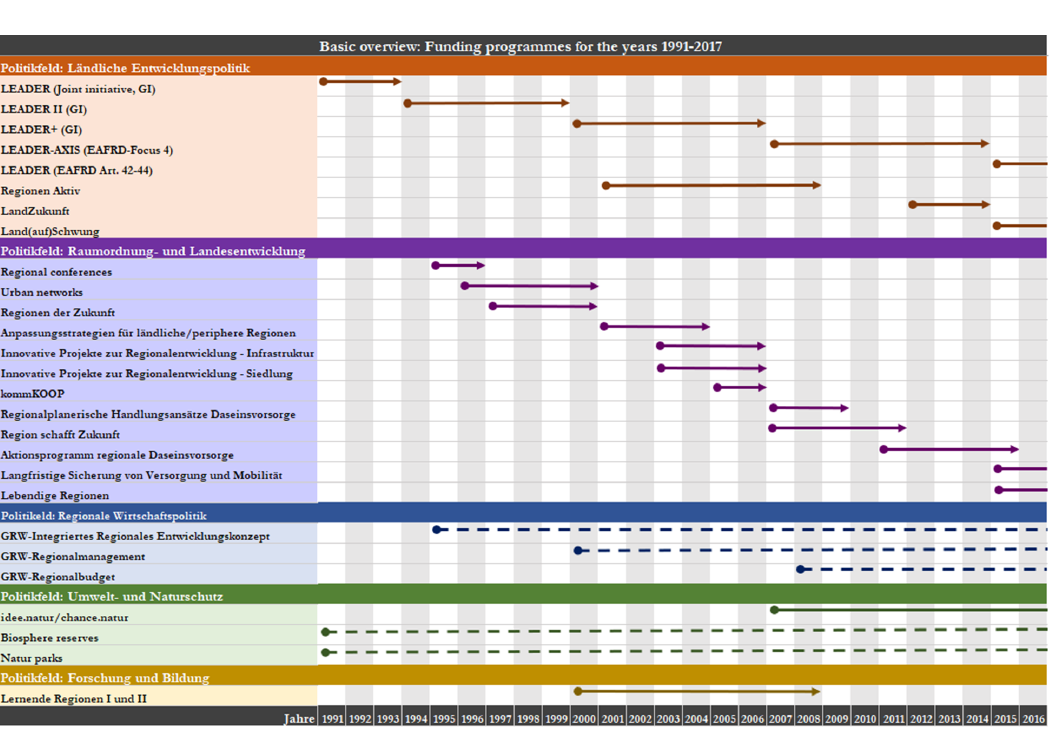
Figure 2. Basic overview of the programmes, dotted lines: varied starting- and end-points of funding programmes. Source: authors’ compilation (Department of Geography Giessen, Institute for Labour and the Economy Bremen).